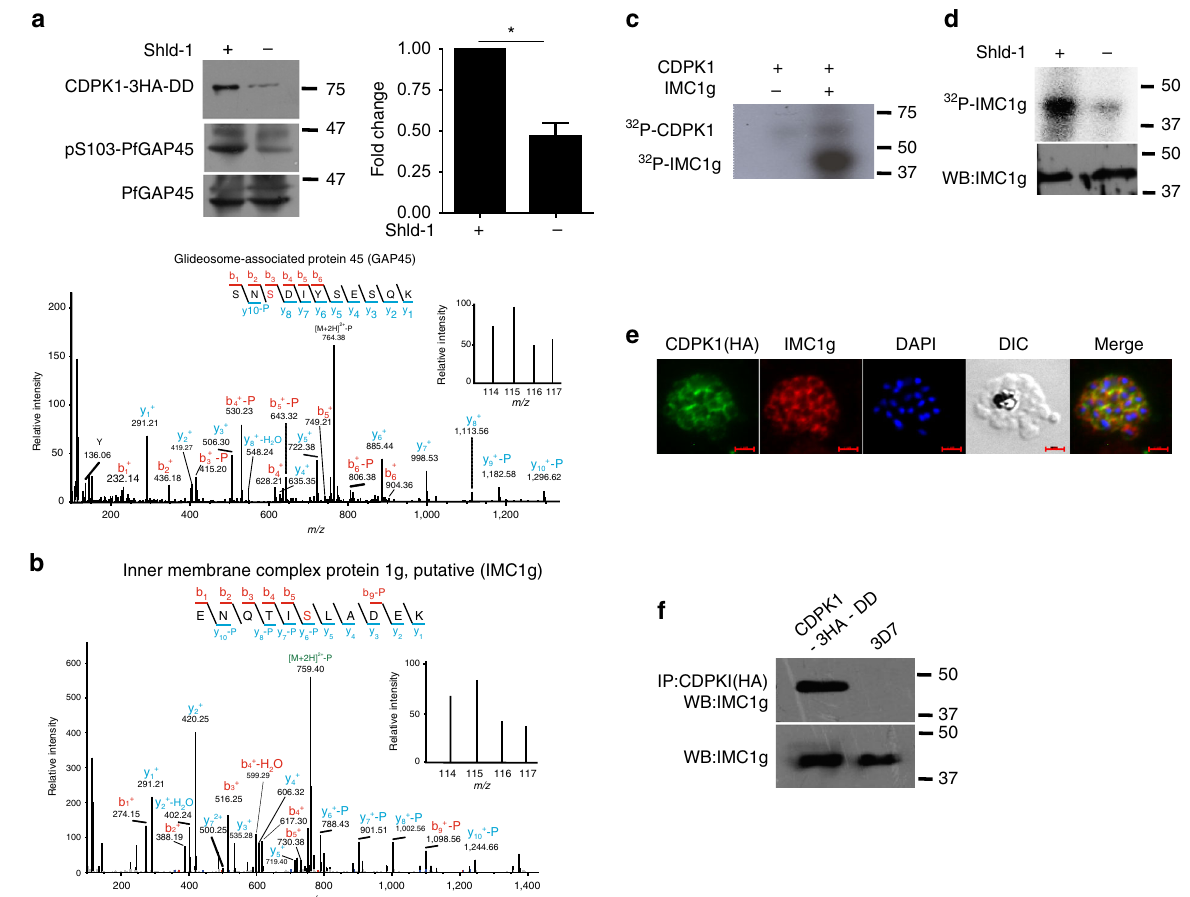
Fig. 2 PfCDPK1 interacts and phosphorylates proteins of IMC and glideosome complex. a The phosphorylation status of PfGAP45 at S103 was assessed after Shld-1 withdrawal from PfCDPK1-3HA-DD parasites. Parasite lysates were prepared from late schizont/segmenter and Western blotting was performed using antibody against PfGAP45 or its form which is phosphorylated at S103 15 . Right Panel , Densitometry was performed for pS103-PfGAP45 bands and was normalized with respect to the WT PfGAP45 (Mean ± s.e.m., * n = 3, p < 0.0001, t -test). Lower Panel , MS/MS spectra for S103 containing phosphopeptide is provided, which indicates differential phosphorylation at this site. b MS/MS spectra of phosphopeptides from IMC1g protein, which was differentially phosphorylated upon PfCDPK1 depletion. c Recombinant 6xHis-PfCDPK1 was used to phosphorylate recombinant 6xHis-IMC1g in a kinase assay using γ 32- P[ATP]. The assay mix was electrophoresed on a SDS-PAGE gel and phosphate incorporation was observed by autoradiography. d PfCDPK1-3HA-DD parasites were synchronized and cultured in the presence or absence of Shld-1. Parasites were labeled with 32 P-orthophosphate and IMC1g was immunoprecipitated. IMC1g-IP was subjected to phosphorimaging and parasite lysate was used for Western blotting with anti-IMC1g. e IFA was performed on PfCDPK1-3HA-DD parasites using anti-HA antibody to detect CDPK1 and anti-IMC1g antisera. Scale bar is 2 µ m. f PfCDPK1 was immunoprecipitated from PfCDPK1-3HA-DD or 3D7 (control) parasites using anti-HA antibody. Western blotting was performed on both PfCDPK1-IP and total lysate using anti-IMC1g